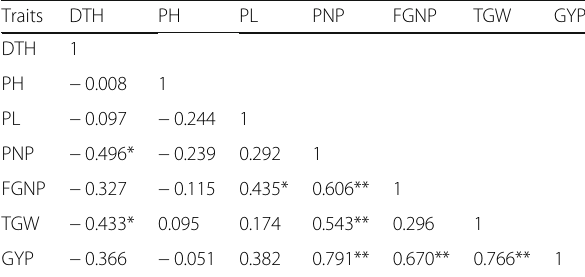
Table 2 Pearson phenotypic correlation for grain yield and its component characters in 22 Egyptian and exotic rice genotypes